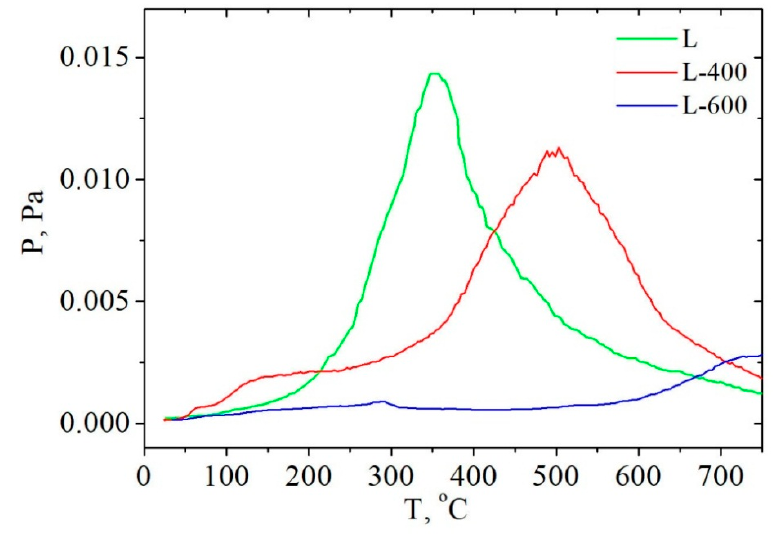
Figure 2. Temperature-pressure (P–T) curves of rice husk hydrolytic lignin and its carbonization products pyrolysis.